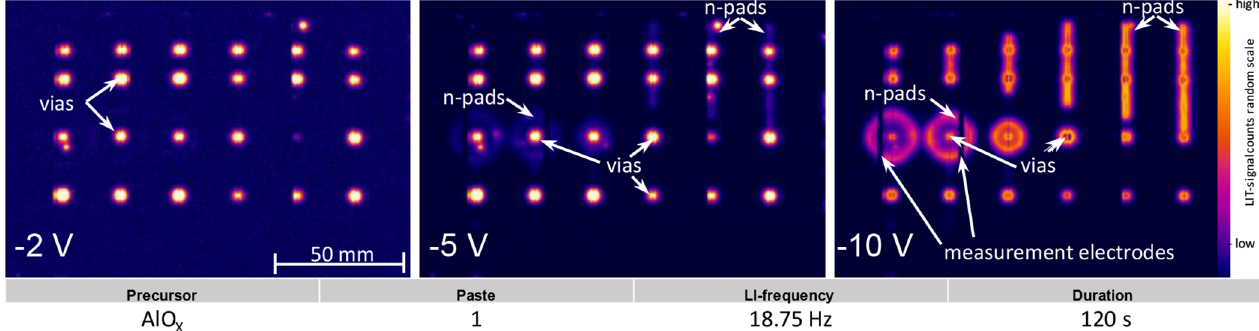
Fig. 6. LIT images of Schottky and MIS contact (AlO X ) combined in via and n -pads. At (cid:1) 2 V the current passes through the Schottky contact in the vias. At (cid:1) 5V the current passes through the Schottky contact in the vias as well as through the MIS contact below the n -pads. At (cid:1) 10 V all MIS contacts contribute signi fi cantly to the current fl ow. Note that the LIT-signal count scales of the pictures are unrelated to visualize the low counts at low